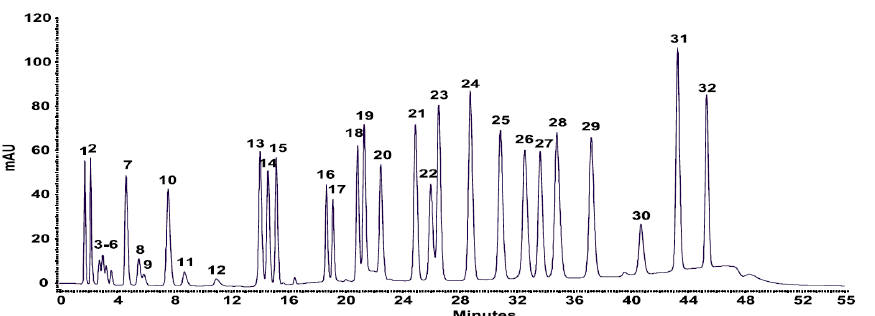
Figure 6. Chromatogram of simultaneous separation of carboxylic acids under single-run chromatographic conditions. Peaks: 1, oxalic; 2, tartaric; 3, malic; 4, malonic; 5, lactic; 6, acetic; 7, maleic; 8, citric; 9, succinic; 10, fumaric; 11, propionic; 12, levulinic; 13, methylsuccinic; 14, pyromellitic; 15, gallic; 16, protocatechuic; 17, 3,5-dihydroxybenzoic; 18, trimellitic; 19, phthalic; 20, 4-hydroxybenzoic; 21, 2,4-dihydroxybenzoic; 22, vanillic; 23, syringic; 24, 2-methoxybenzoic; 25, trimesic; 26, benzoic; 27, ferulic; 28, salicylic; 29, 3-methoxybenzoic; 30, 2-methylbenzoic; 31, cinnamic; 32, 3-methoxycinnamic acid. [39]—Reproduced with the permission of Springer Nature.